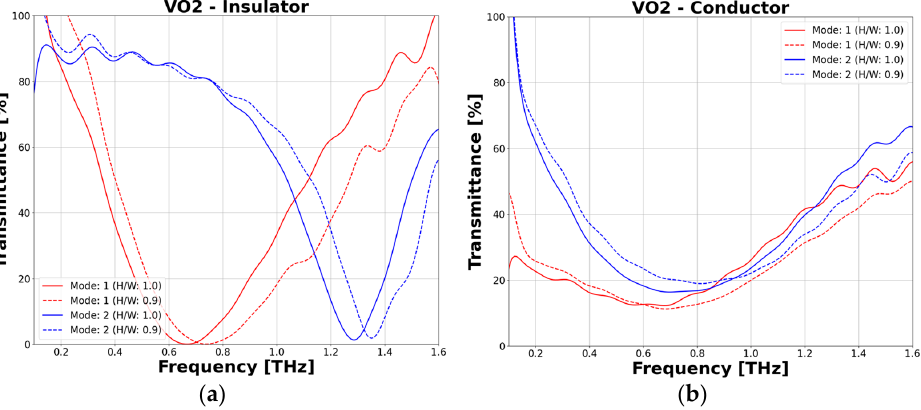
Figure 9. THz transmittance of the two metamaterials with different aspect ratios depending on the polarization of the incident THz wave when VO 2 is in the ( a ) insulator state and ( b ) conductor state.